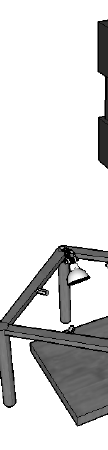
Figure 1. Experimental setup used for hyperspectral imaging.